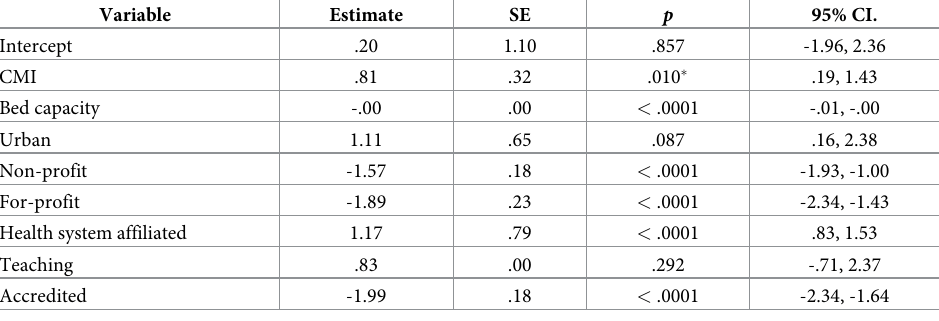
Table 3. The association between hospital characteristics and incidence rates of central line-associated blood- stream infection in California community